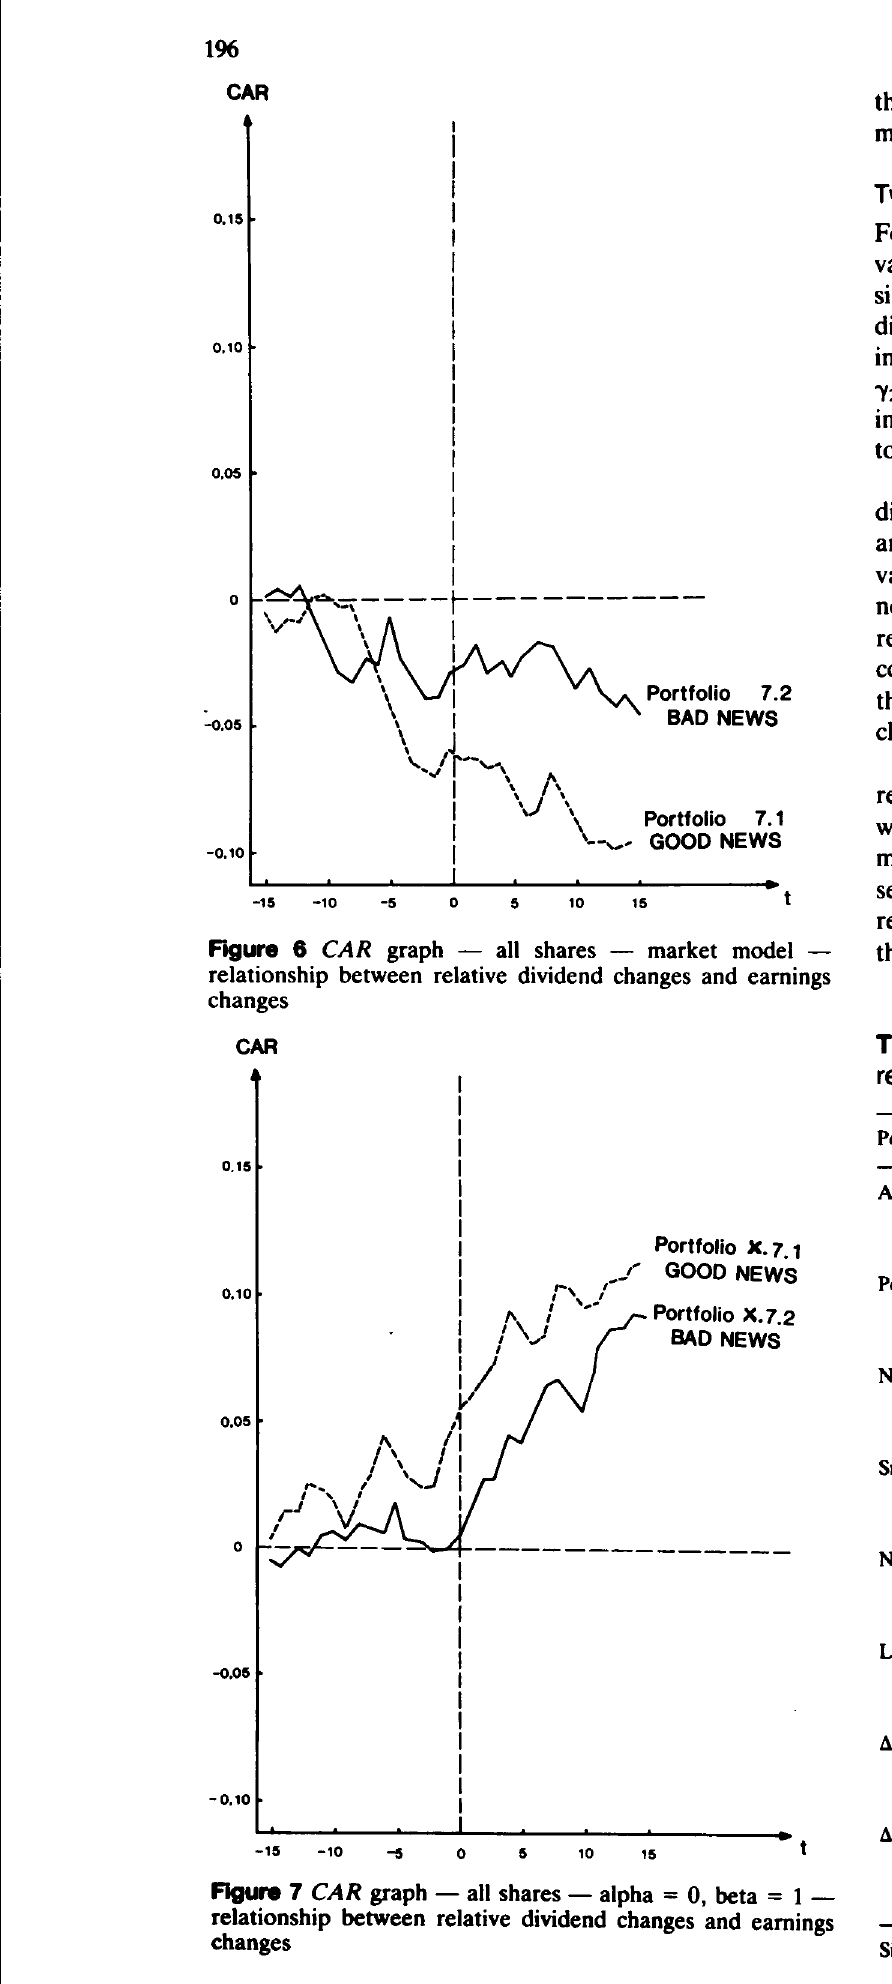
Figure 7 CAR graph - all shares - alpha= 0, beta = 1 - relationship between relative dividend changes and earnings